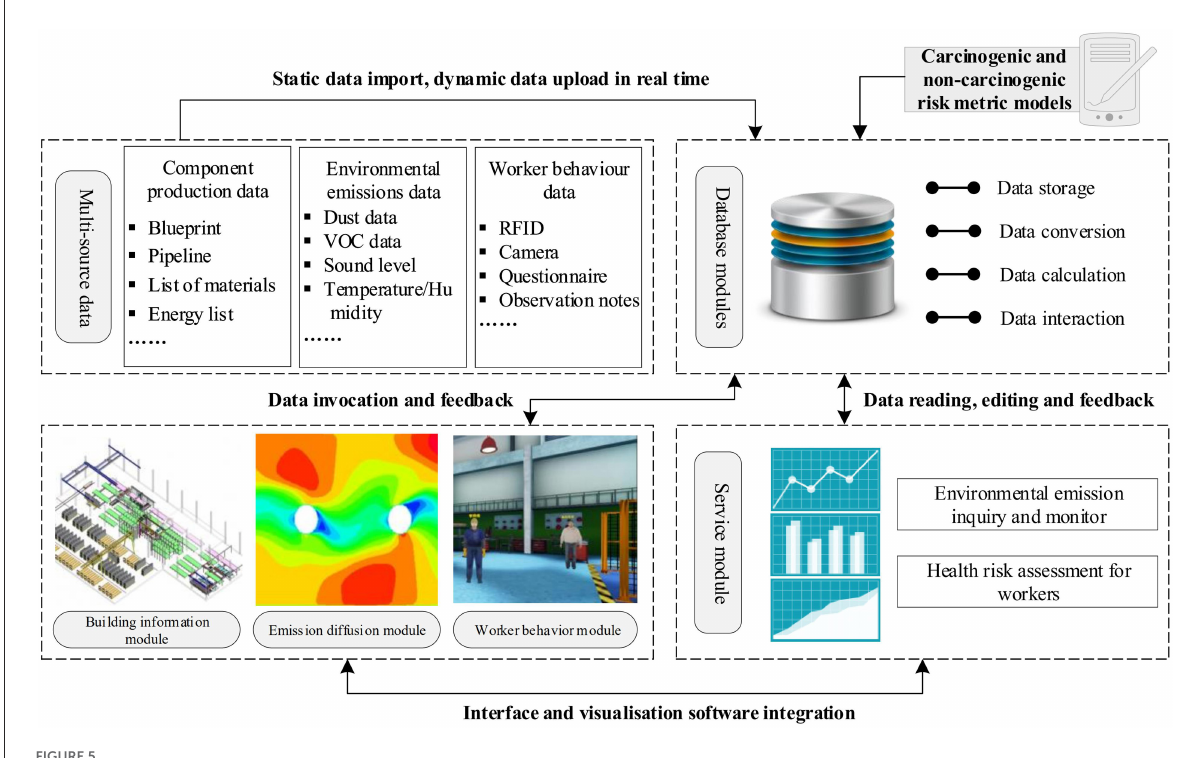
FIGURE5 Simulation and evaluation model for occupational health risk